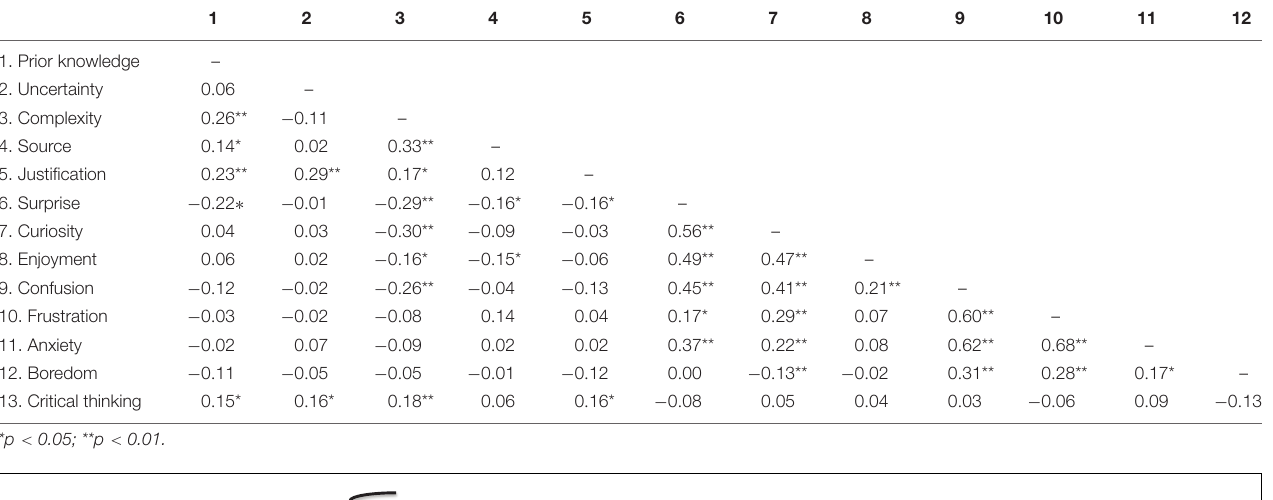
TABLE 4 | Correlations between variables.